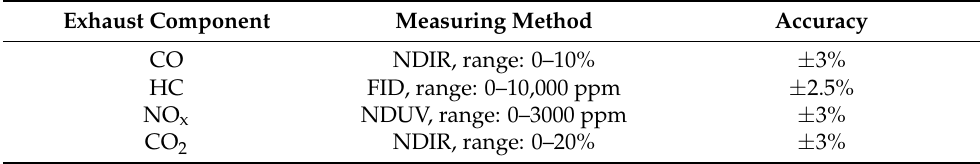
Table 3. Characteristics of the SEMTECH DS exhaust gas analyser.